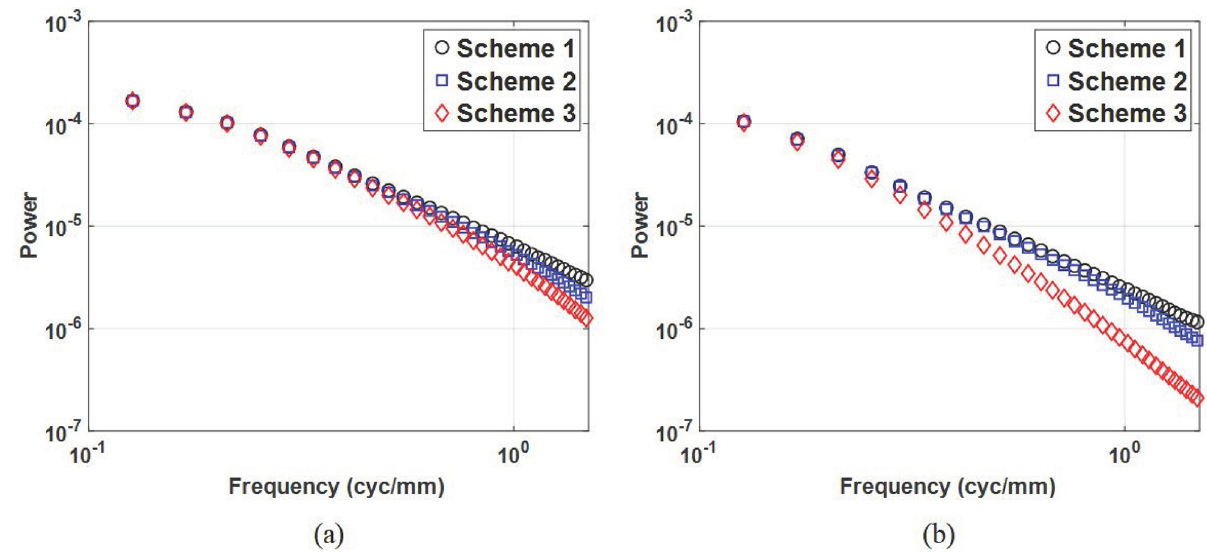
Fig 8. Noise power spectrum. Noise power spectrum from the reconstructed in-plane images for data acquisition angles of (a) 20˚ and (b) 60˚.